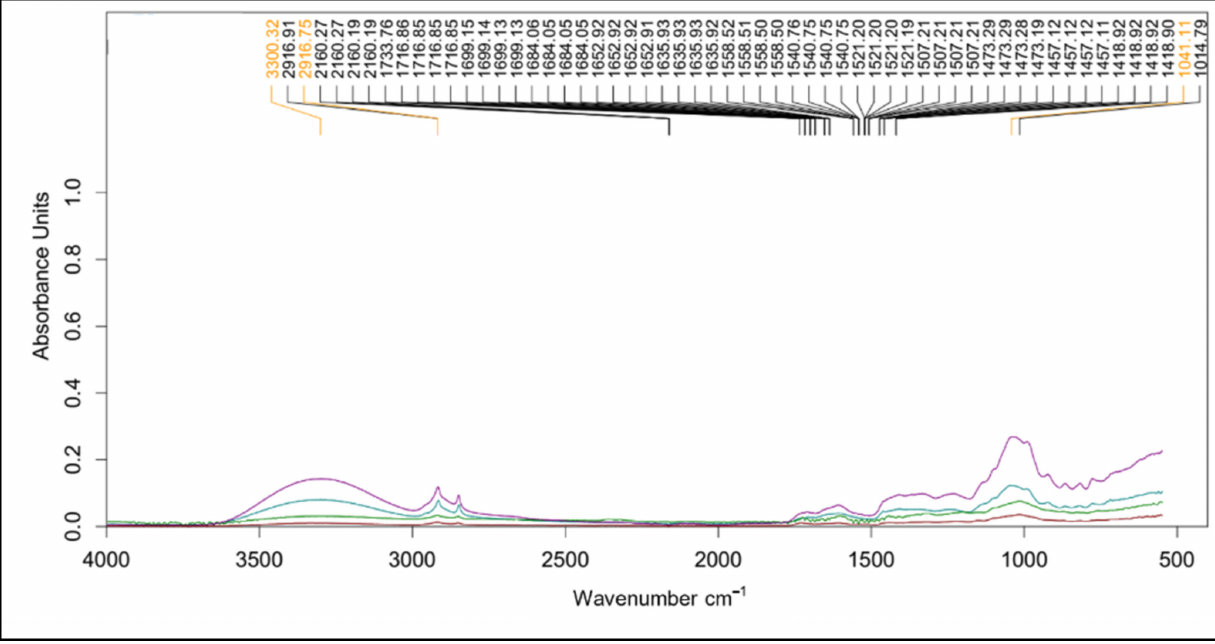
Figure 2. The FT-IR spectra of mango peels var. ‘mahachanok’ ( — ), ‘chok anan’ ( — ), ‘nam dok mai’ ( — ), and ‘kaew’ ( — ) from 600 to 4000 cm − 1 ( x -axis) in terms of absorbance units ( y